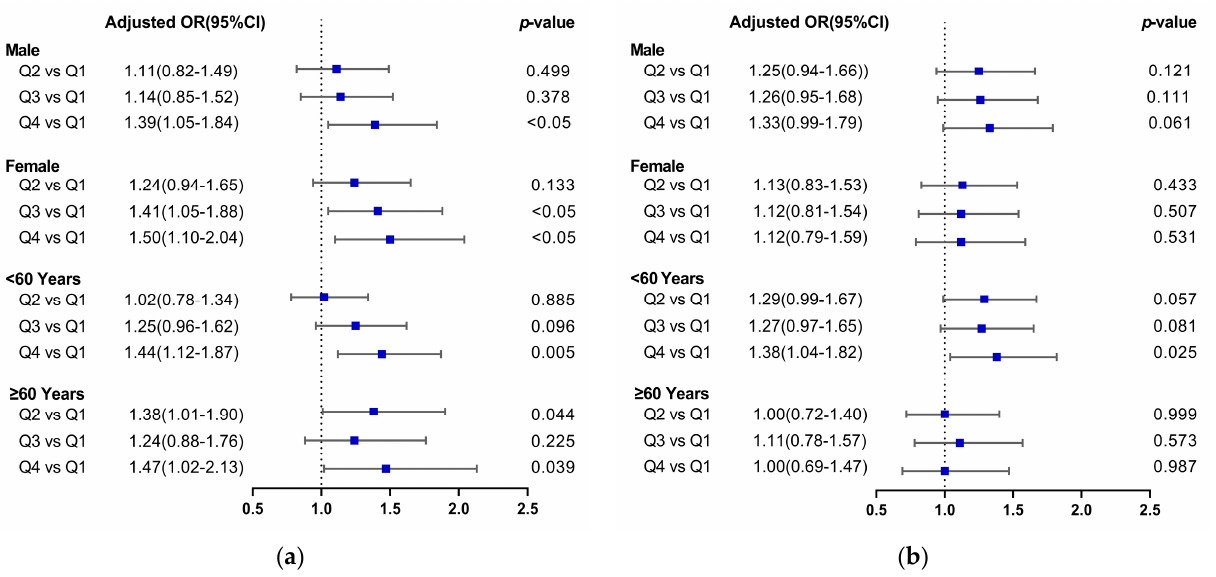
Figure 2. Forest plots of the relationship between dietary acid load (DAL) and the risk of hyperu- ricemia. (Plot ( a ) PRAL and hyperuricemia risk; Plot ( b ) NEAP and hyperuricemia risk).